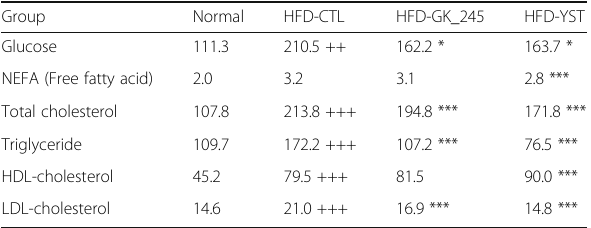
Table 3 Serum lipid and glucose levels Group Normal HFD-CTL